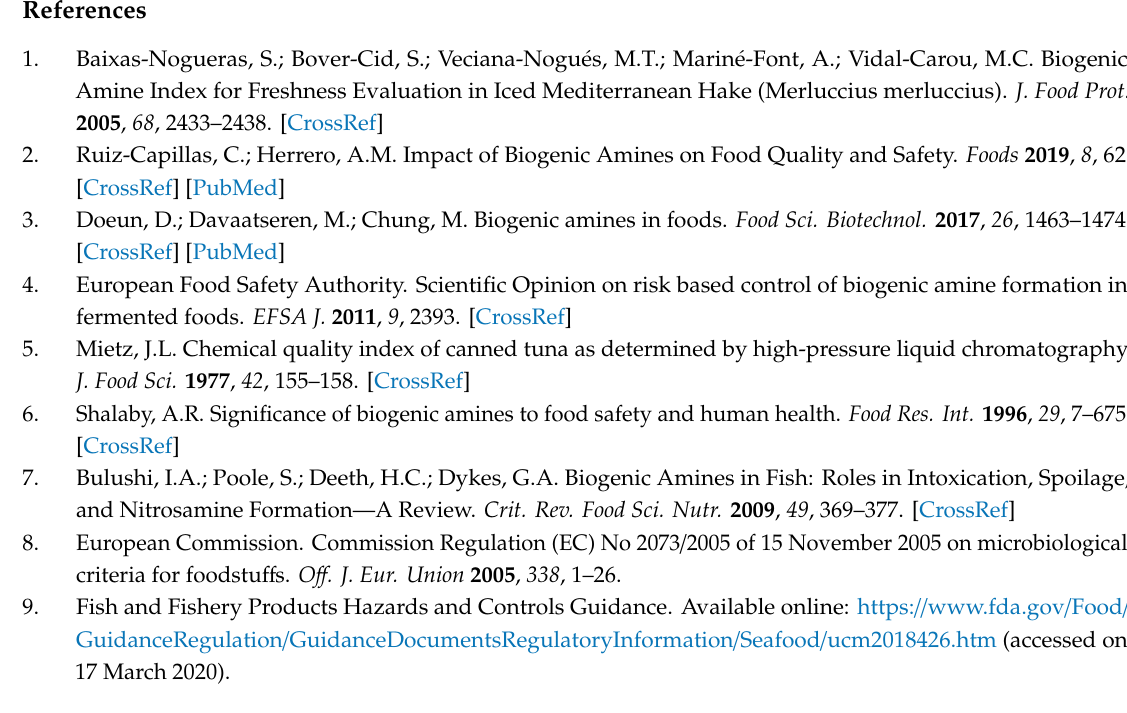
Figure S1: (A) HPLC-FLD; (B) HPLC-UV chromatogram of sea bass tissue, fortified only with the internal standard 1,7 diaminoheptane (IS) at 4.8 mg kg − 1 , Figure S2: Reconstructed Ion Chromatograms of a 5 µ g mL − 1 histamine pyrene derivative at m / z 640.3–641.3 [M + H] + and 662.3–653.3 [M + Na] + , Figure S3: Full scan spectrum ( m / z 500–1500) at the retention time of cadaverine pyrene derivative (8.4 min) of a 5 µ g mL − 1 standard solution, Figure S4: Reconstructed Ion Chromatograms of a 5 µ g mL − 1 cadaverine pyrene derivative at m / z 631.3–632.3 [M + H] + , 652.3–653.3 [M + Na] + and 1283.4–1284.4 [2M + Na] + , Figure S5: Matrix matched calibration curves of sea bass sample with Fluorescence